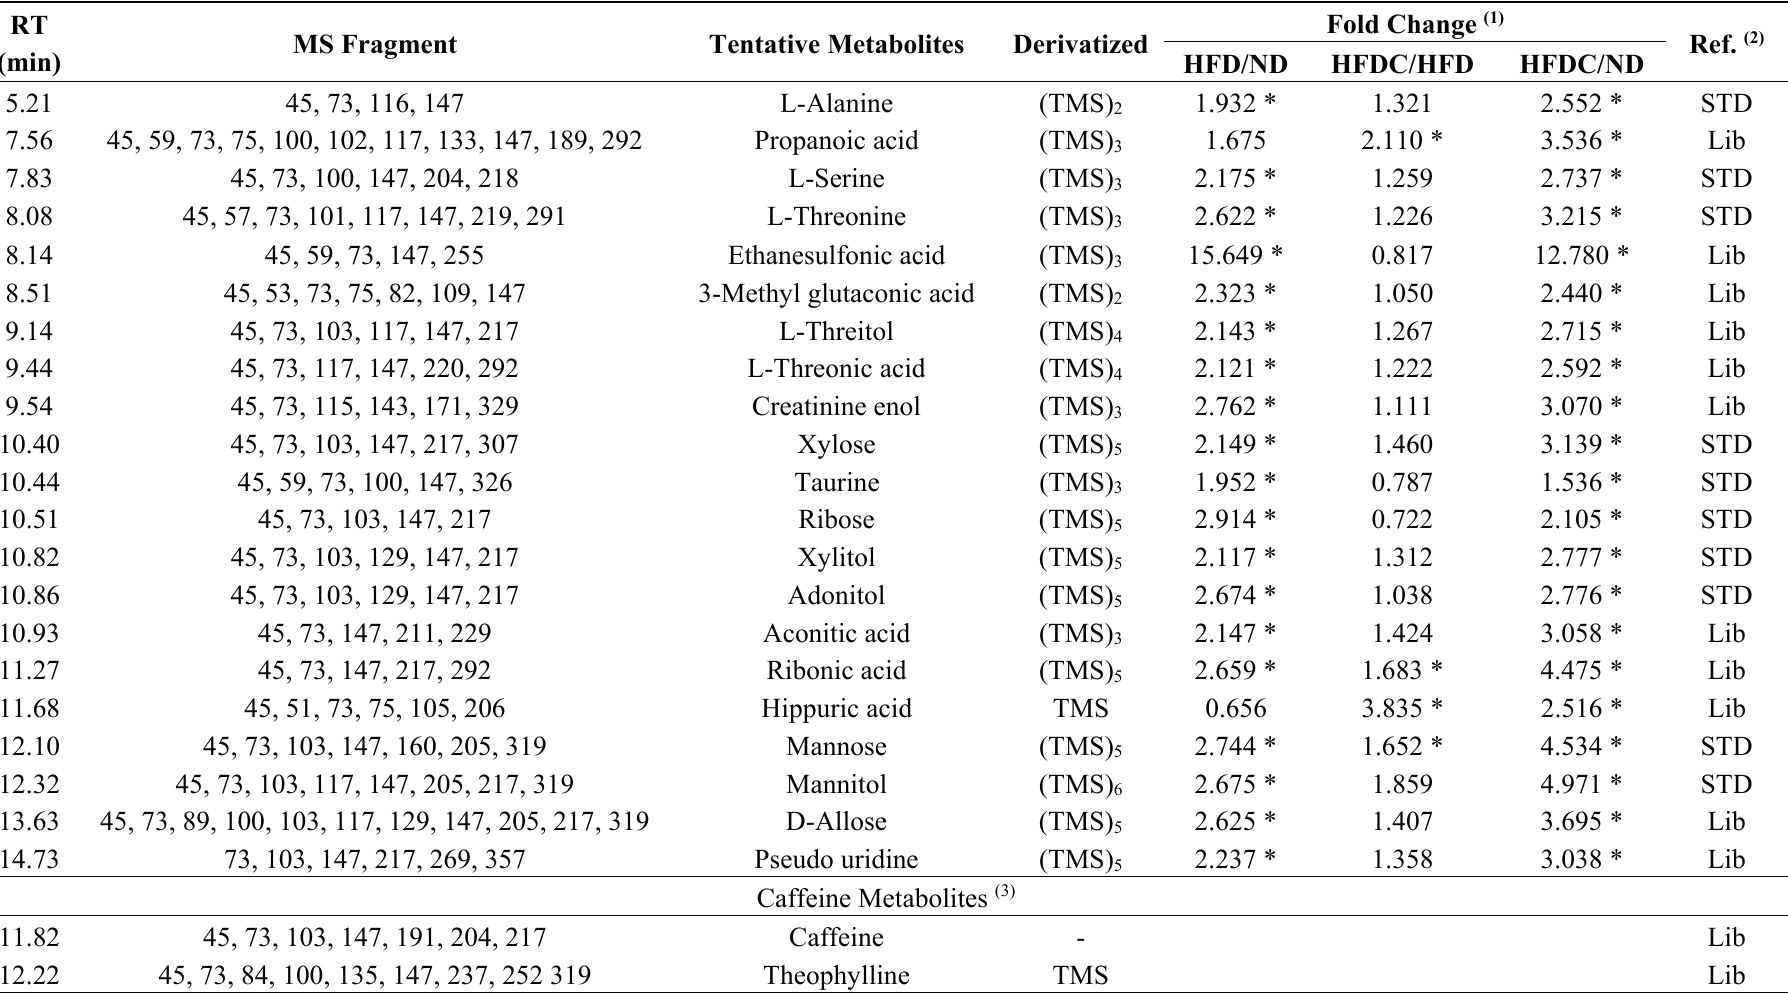
Table 3. Discriminated metabolites of the urine identified using